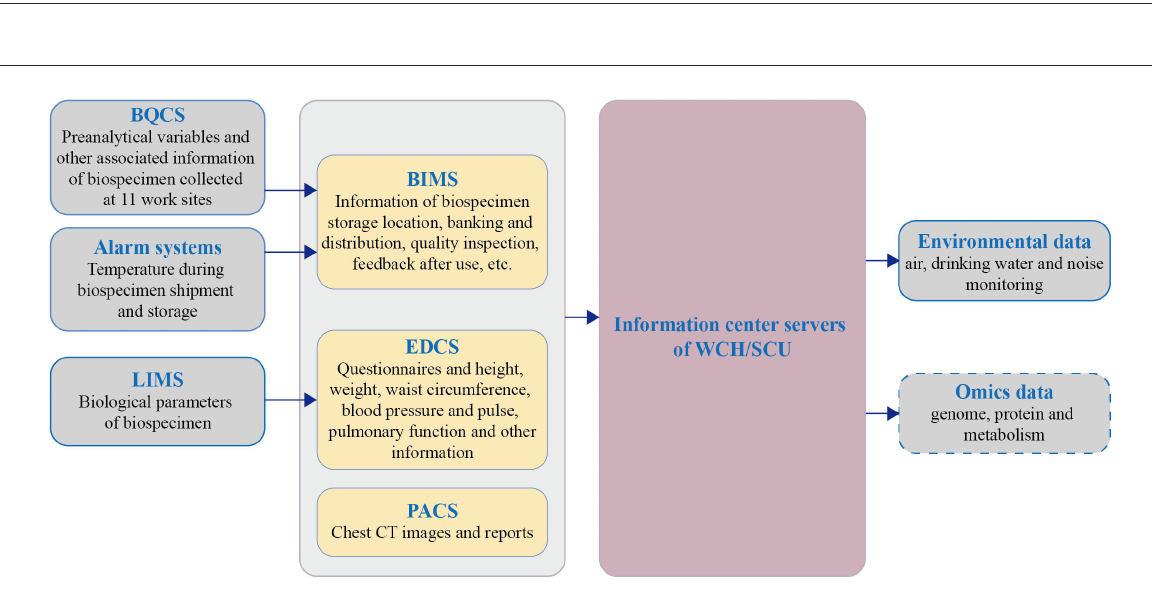
FIGURE3 Flow diagram of information management for NPCS. BQCS, biospecimen quality control system; LIMS, laboratory information management system; BIMS, Biobank information management system; EDCS, electronic data capture system; PACS, picture archiving and communication system; WCH/SCU, West China Hospital of Sichuan